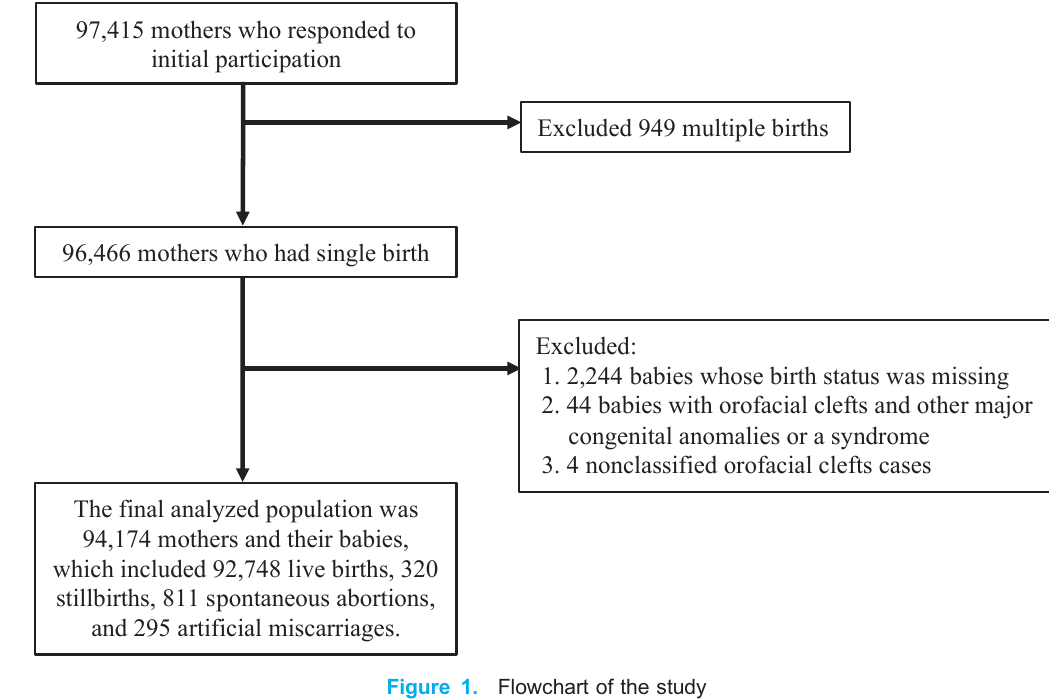
Figure 1. Flowchart of the